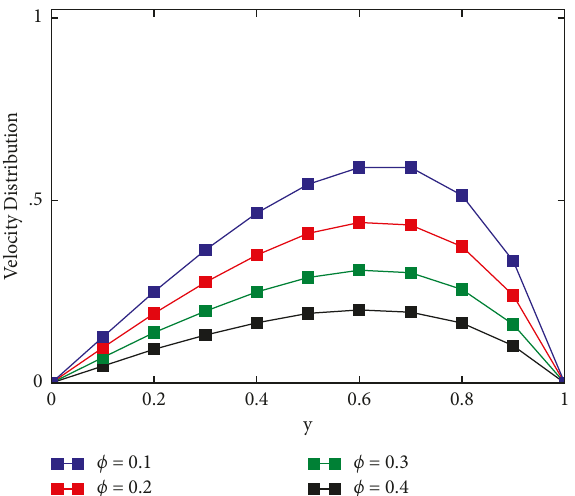
Figure 10: Impact of ϕ